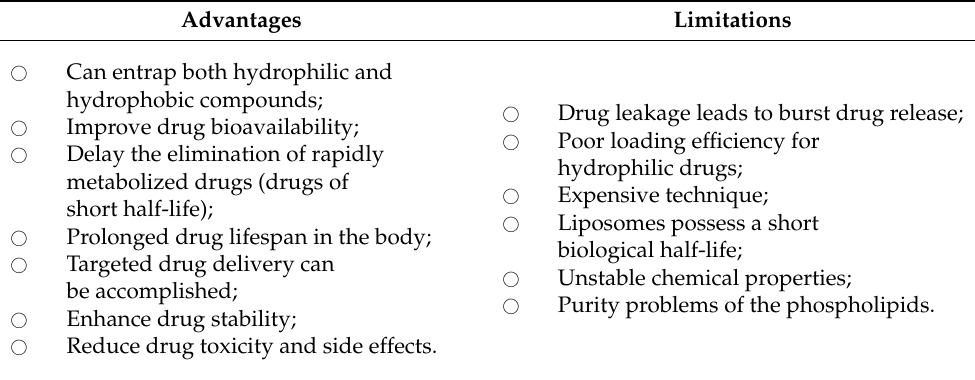
Table 4. The main advantages and limitations of lipid-based vesicular DDSs. Advantages